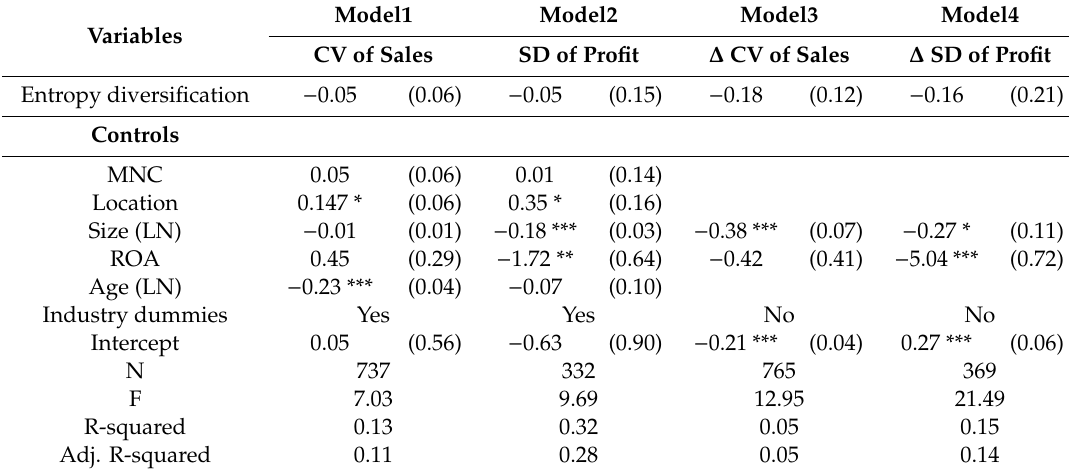
Table 3. Comparison of Diversification Models, as Measured by the Entropy Method for Corporate Risk.